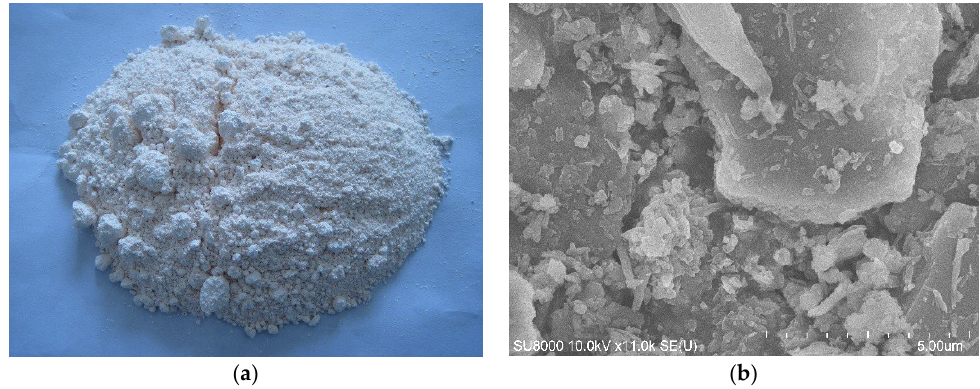
Figure 1. Scanning electron micrographs (SEM) of metakaolin. ( a ) Appearance; ( b ) microstructure.